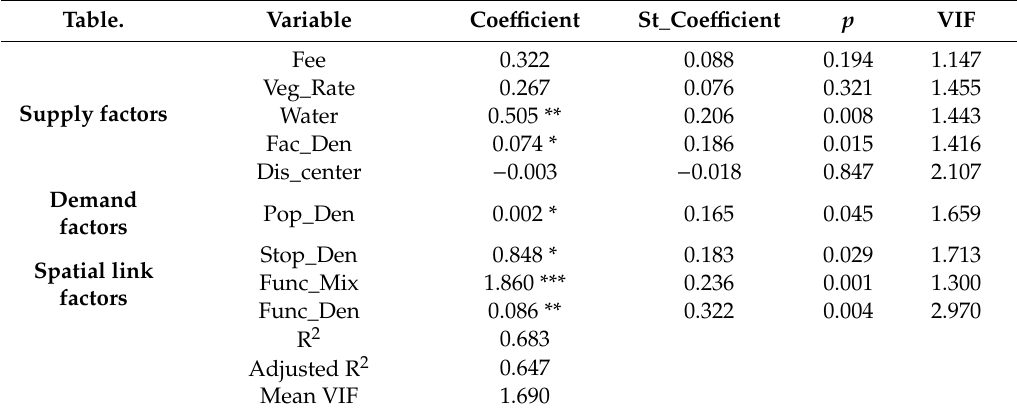
Table 4. From multiple linear regression analyses of park vitality on di ff erent factors.